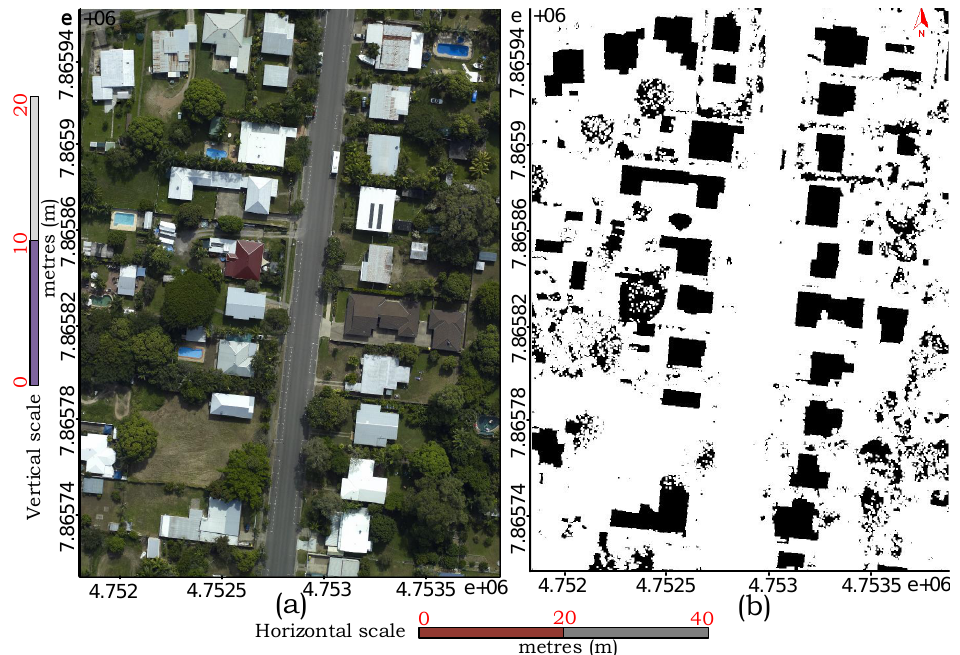
Figure 3. Sample data: ( a ) RGB Orthoimage; ( b ) The building